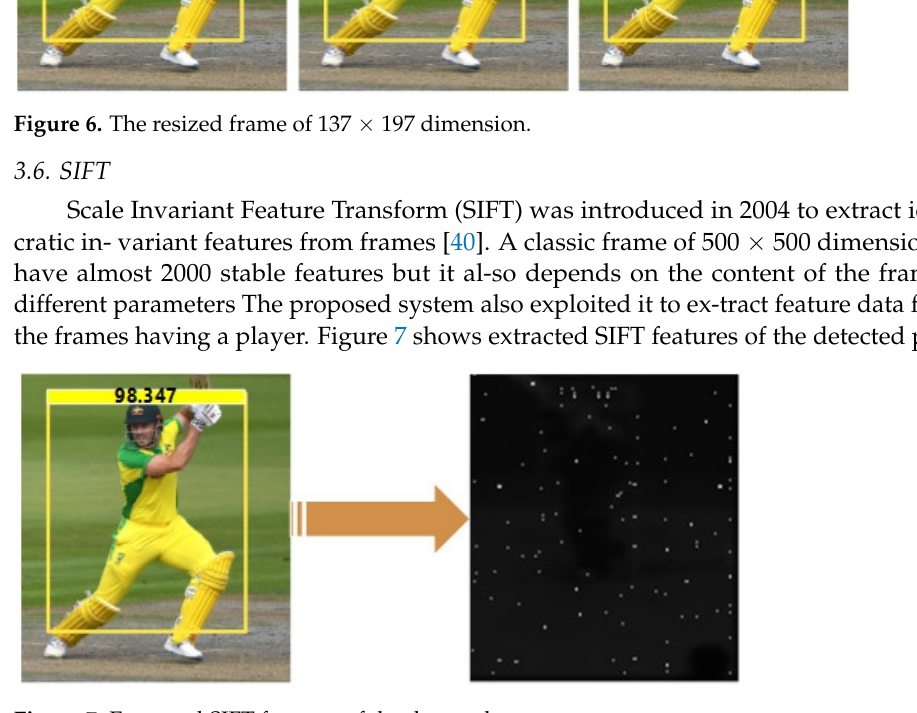
Algorithm 1 Algorithm for the proposed system